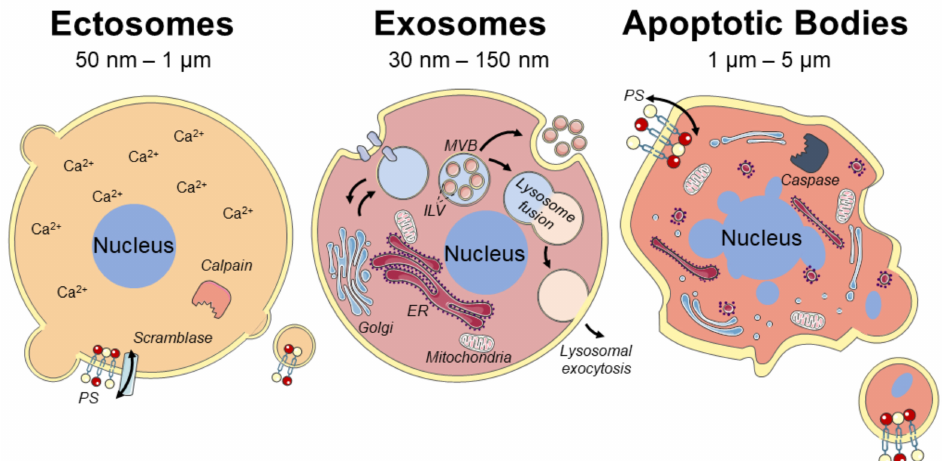
Figure 1. Subtypes of extracellular vesicles (EVs) based on their possible biogenesis pathways. EVs can appear as ectosomes that bleb from the cell membrane, as exosomes that are formed inside the cell after endocytosis, or as apoptotic bodies that derive from cells undergoing apoptosis. MVB, multi vesicular body; ILV, intra luminal vesicle; ER, endoplasmic reticulum; PS, phosphatidylserine. The figure was modified from Servier Medical Art, licensed under a Creative Common Attribution 3.0 Generic License (http://smart.servier.com/, accessed on 20 January